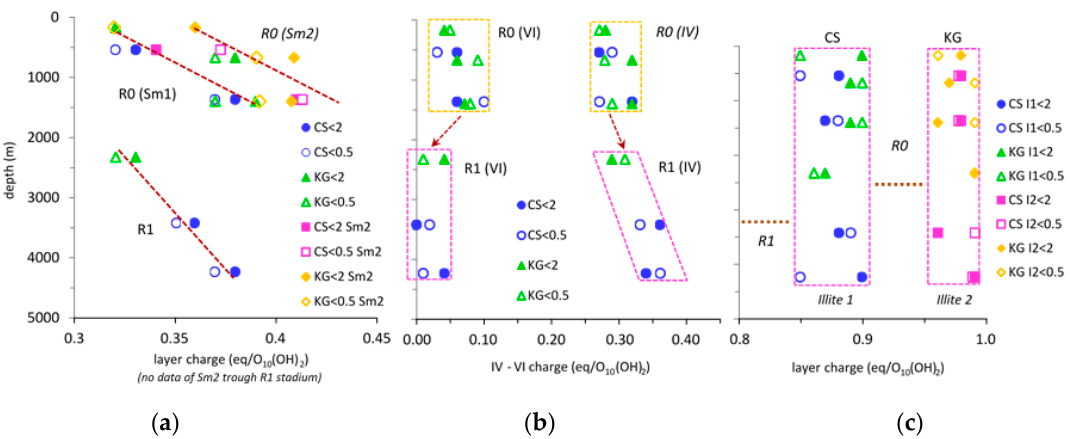
Figure 4. Variations in the charge of the 2:1 expandable layers with depth through R0 and R1 mineralogical intervals of the Álava Trough sections: ( a ) Total layer charge; ( b ) tetrahedral and octahedral charges; ( c ) layer charge of expandable micaceous phases treated with n-alkylammioum.